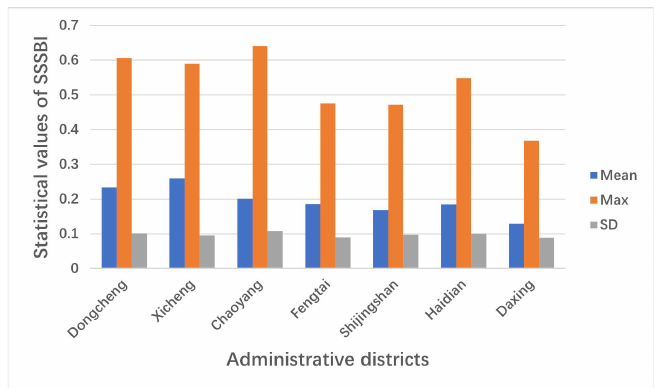
Figure 11. Mean, maximum (Max), and standard deviation (SD) of the SSSBI for different administrative districts within different administrative districts.